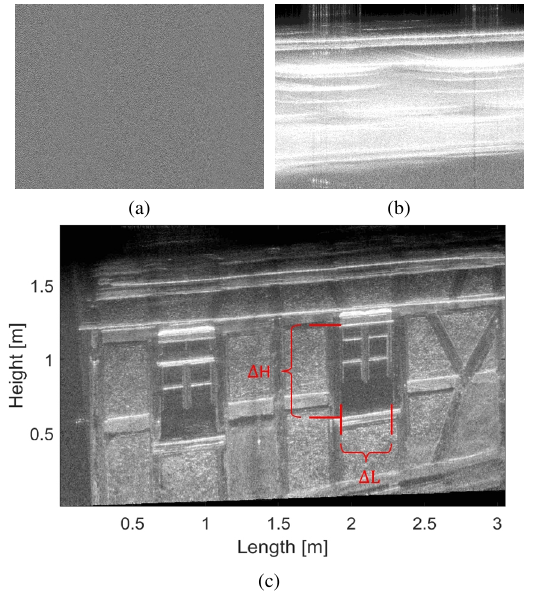
Figure 8. Sequence of facade focusing. (a) Collected real valued raw data. (b) Range compressed data. (c) Azimuth compressed facade image in vertical image geometry.